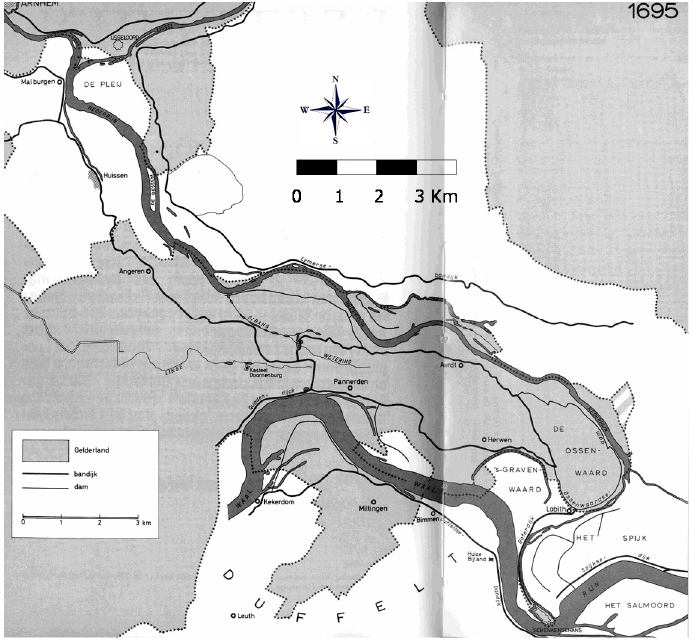
Figure 4. Rhine bifurcations, end of 17th century (copyright [5]).